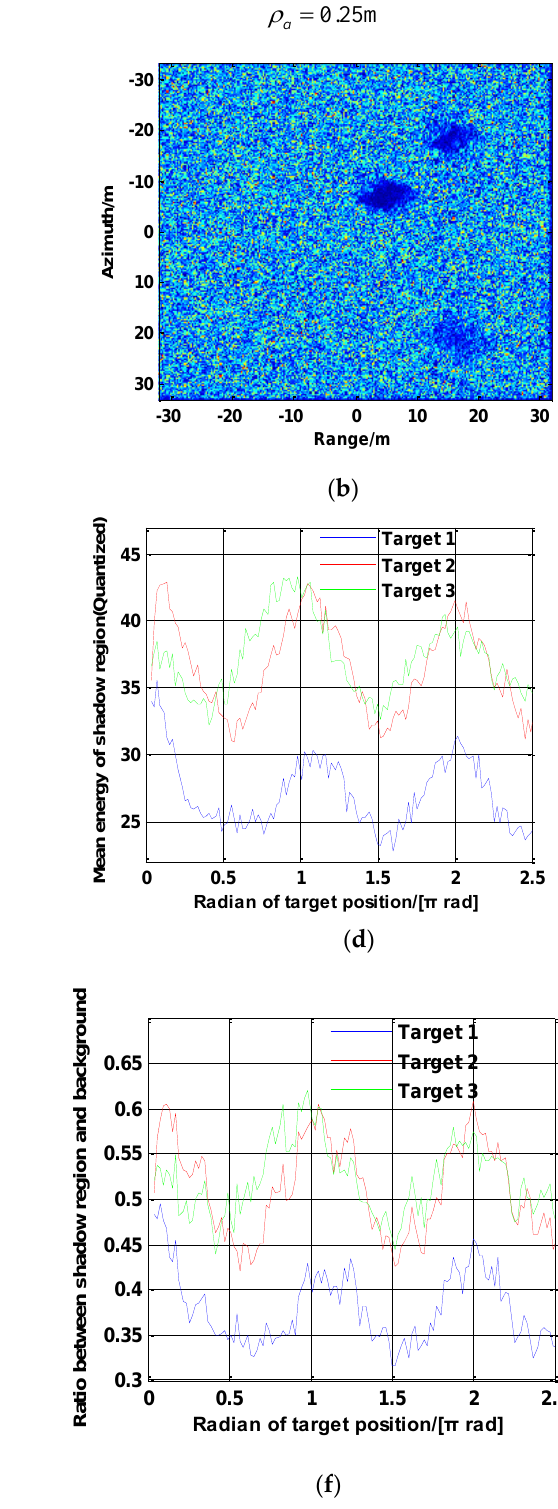
Figure 16. Results of experiment 2. The meanings of ( a–f ) are the same as those of ( a–f ) in Figure 15.